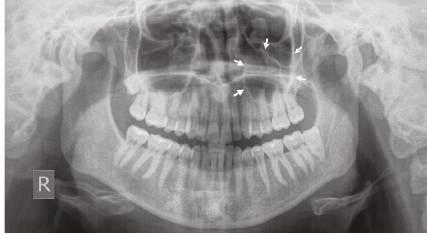
Figure 6: Control OPG with no radiological signs of recurrence.